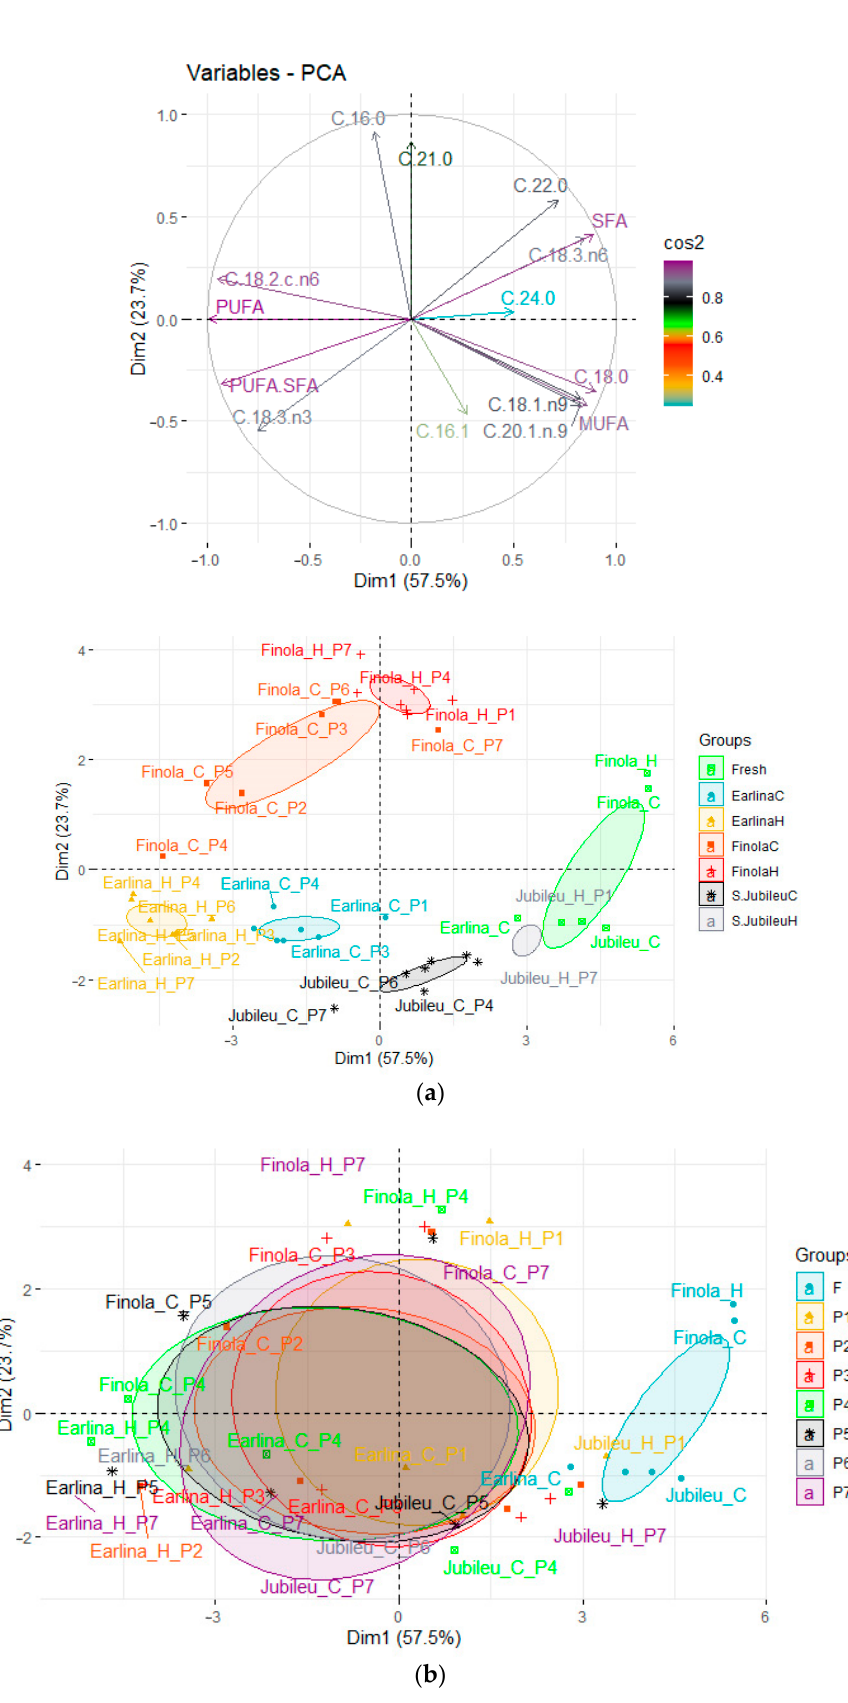
Figure 2. Principal component analysis (PCA) of the loading plot and score plots of data from the fatty acid profiles of fresh and bleached hemp oils, where: ( a ) grouped oil type; ( b ) grouped BE type.